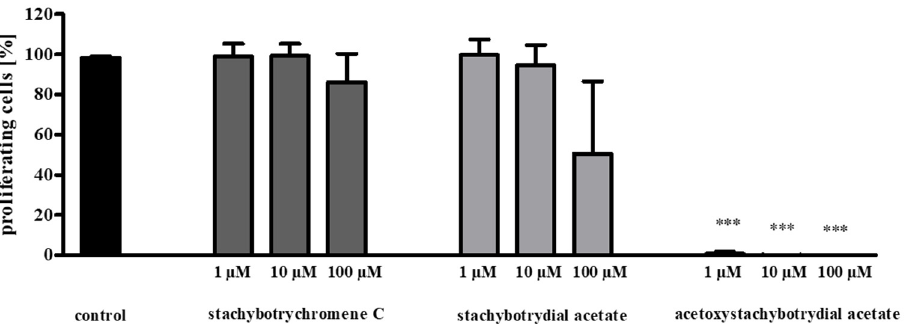
Figure 7. Quantification of the antiproliferative effect of stachybotrychromene C, stachybotrydial acetate and acetoxystachybotrydial acetate on MCF7 NucLight Green cells after 24 h of incubation. Numbers of proliferating cells were determined by EdU assay. Results are shown as a percent of proliferating cells relative to control cells (with 1% DMSO) and represent the mean (± SD) of three independent experiments. *** p < 0.001. The EC 50 value of acetoxystachybotrydial acetate for the inhibition of tumor cell proliferation after 24 h was determined for MCF7 NucLight green cells (Figure 8) and appeared to be 0.39 µM.